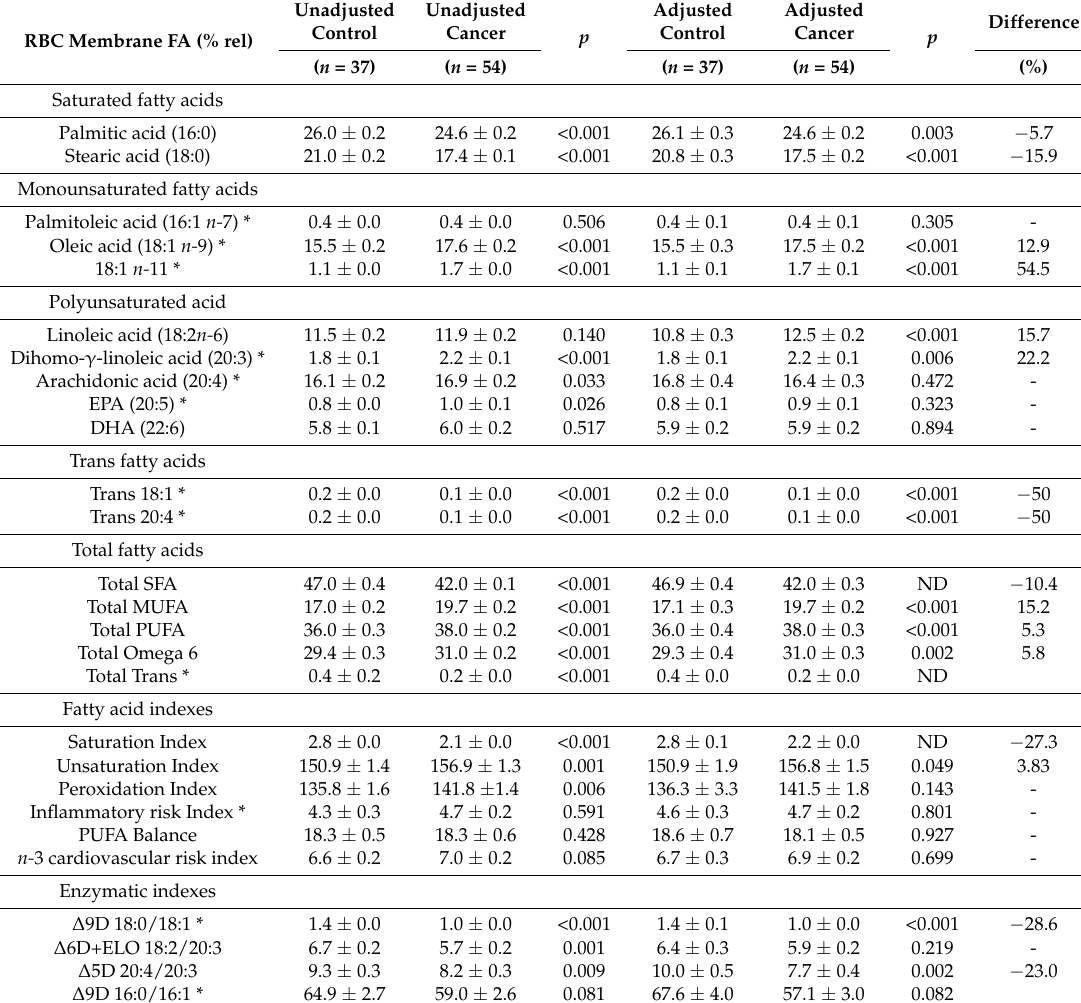
Table 3. Red blood cell (RBC) membrane fatty acid (FA) levels in cancer and control groups.